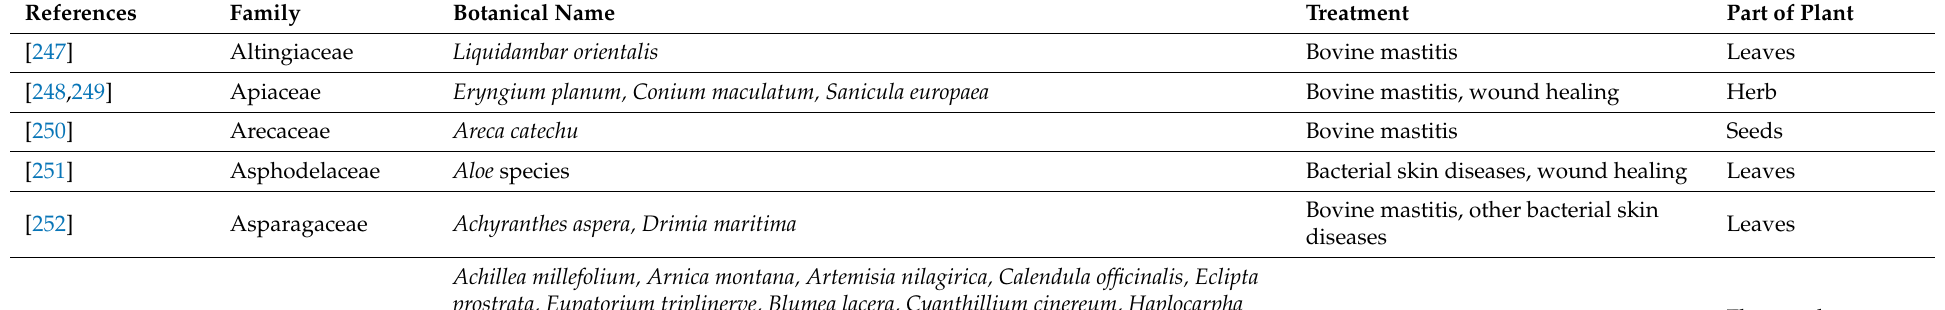
Table 9. List of plants used to treat skin infections in